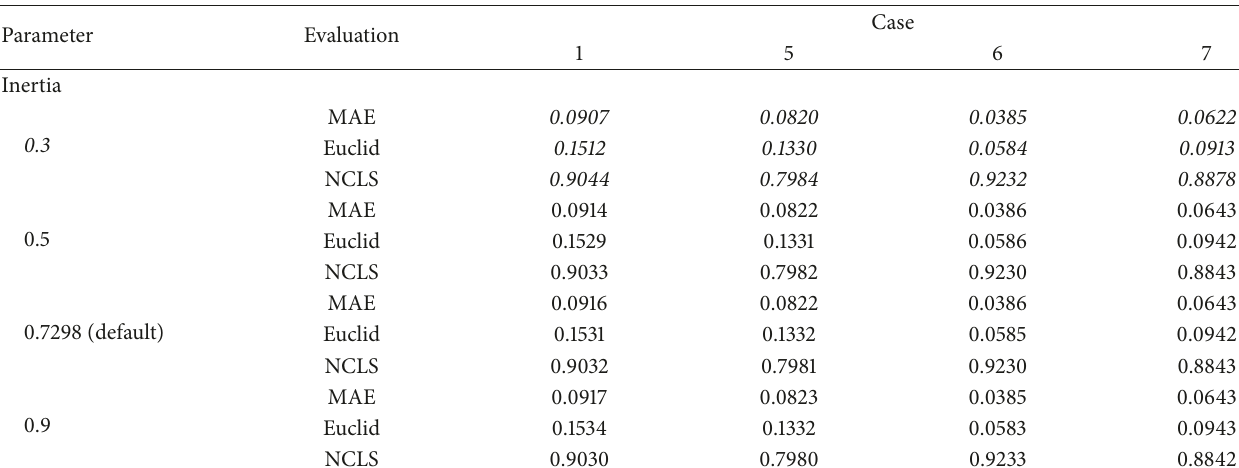
Table 8: Results on parameters of